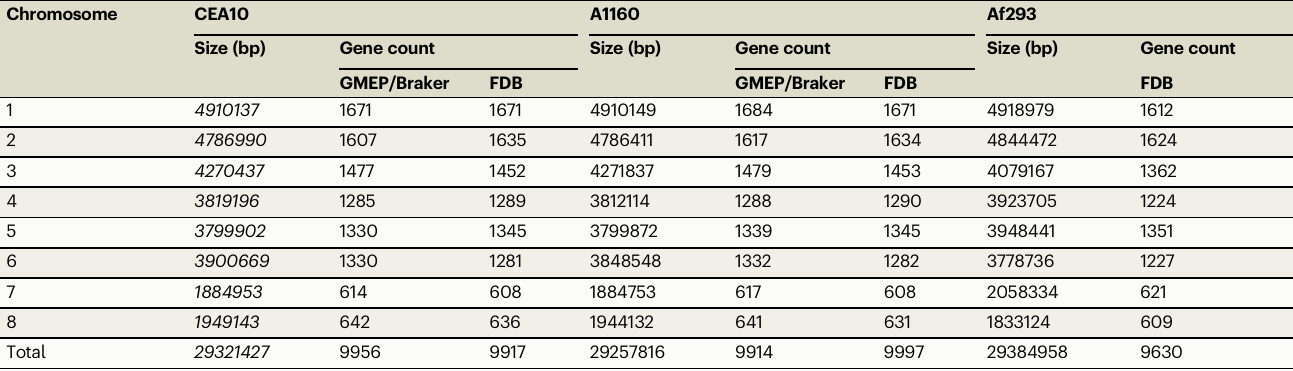
Table 1 | Assembly statistics for assembled chromosomes